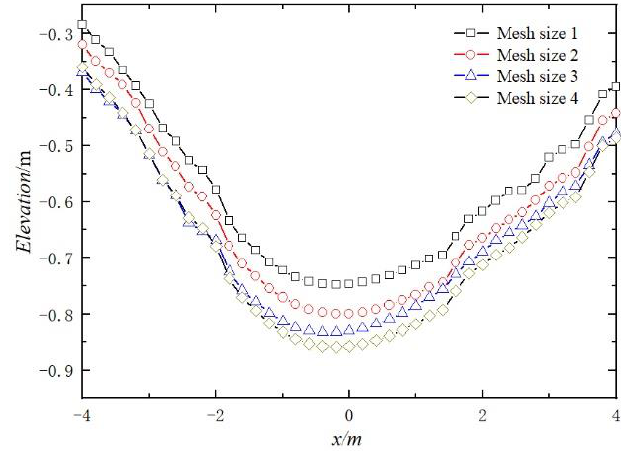
Figure 3. Comparison of the scour hole profiles with different mesh grid sizes.